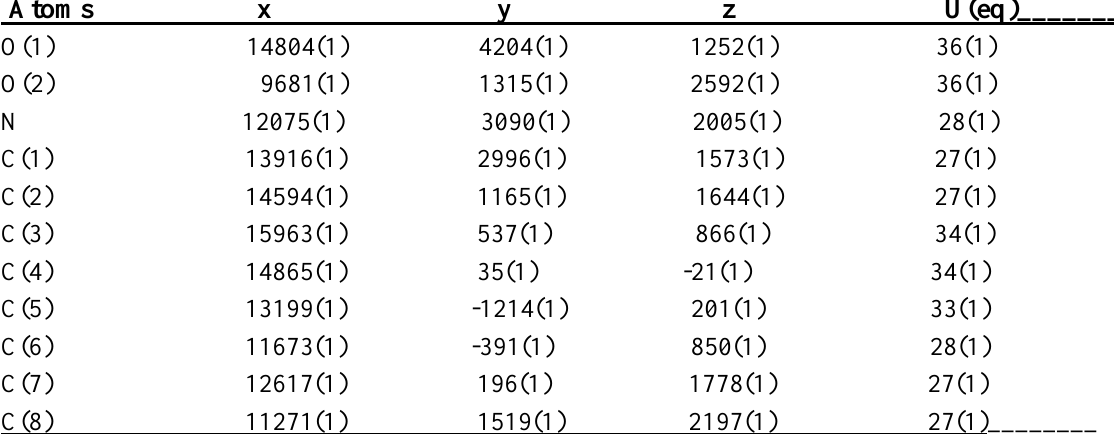
Table 2. Atomic coordinates ( x 104) and equivalent isotropic displacement parameters (Å 2 x 10 3 ) for 3a,4,5,6,7,7a-Hexahydro-1H-isoindole-1,3(2H)-dione. U(eq) is defined as one third of the trace of the orthogonalized U ij tensor.